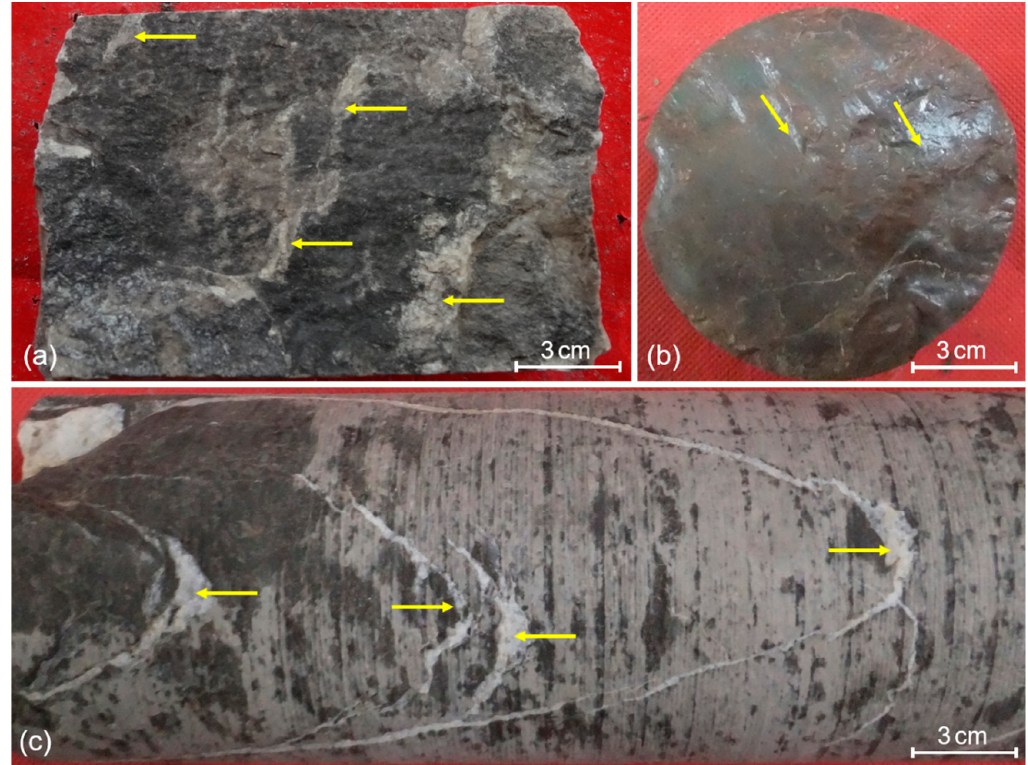
Figure 5. Orientations of tectonic fractures in outcrops of carbonate rocks in the Jizhong Sub-Basin ( n = 1105).